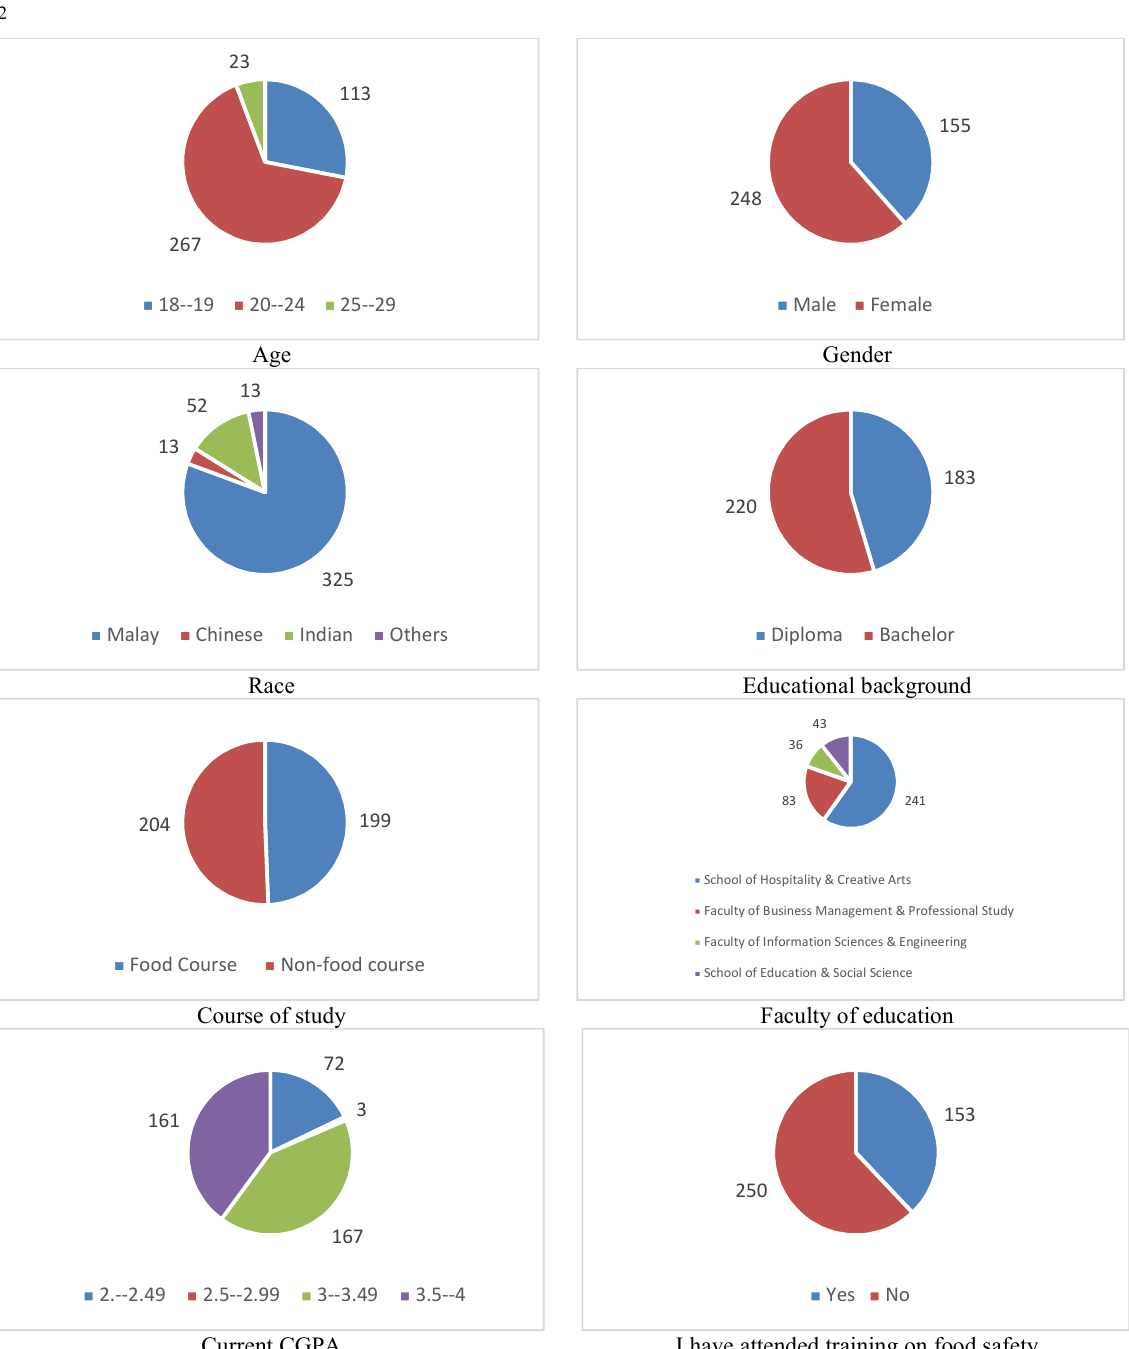
Fig. 1. Personal characteristics of the